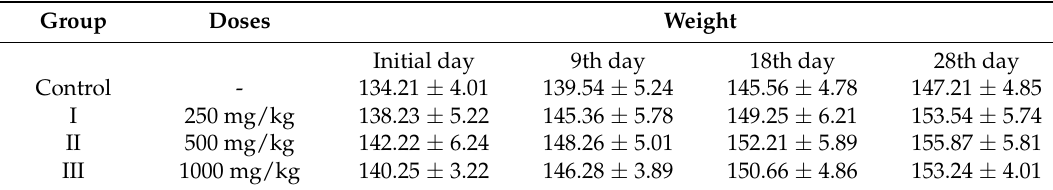
Table 4. The effect of MTE leaves on body weight of rats (g) at different